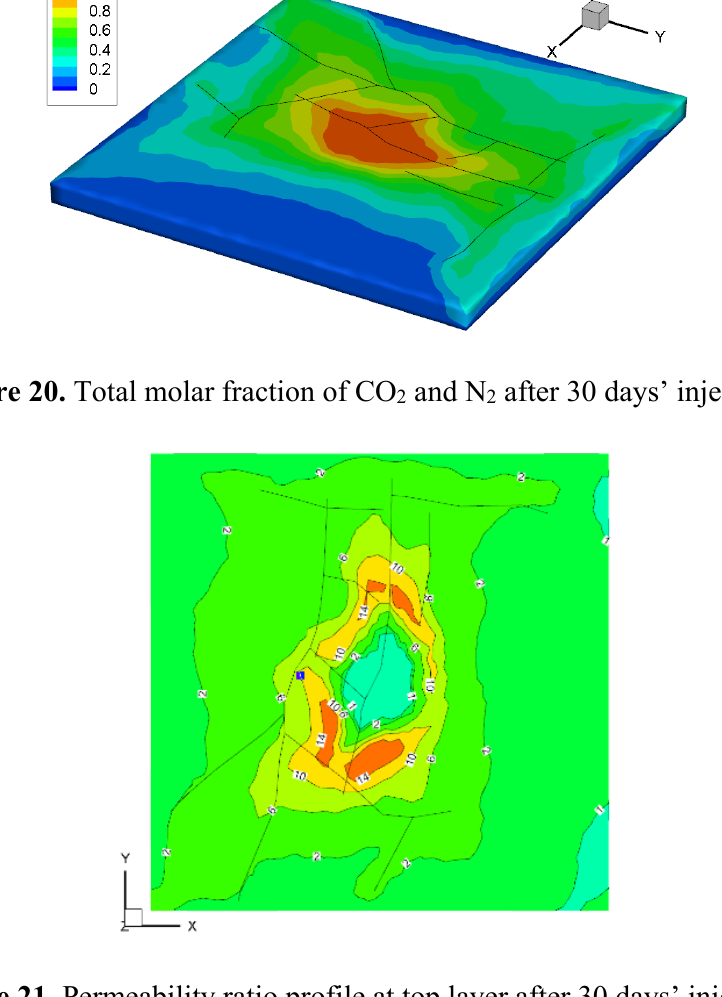
Figure 21. Permeability ratio profile at top layer after 30 days’